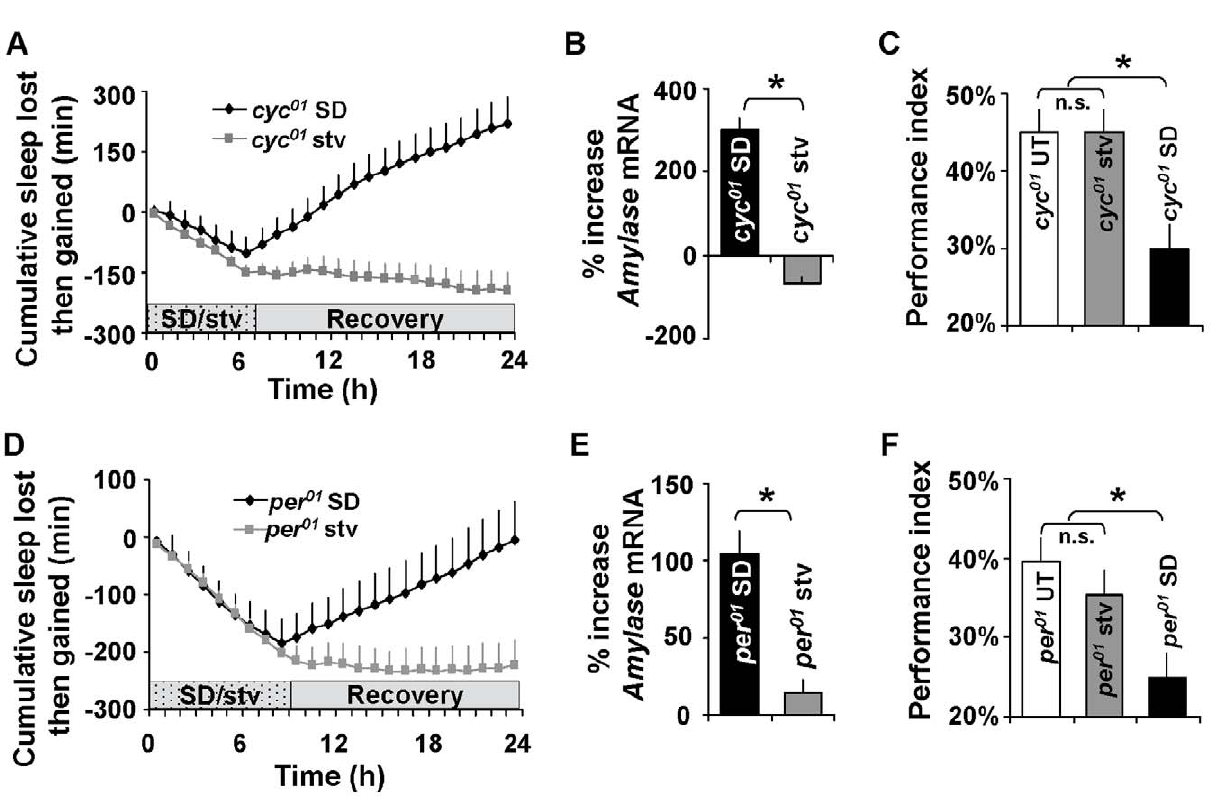
Figure 1. Starvation produces a waking state that does not activate sleep homeostasis. (A) cyc 01 flies show a large homeostatic response after 7 h of sleep deprivation (SD, black) but do not display a homeostatic response following waking induced by 7 h of starvation (stv, gray). The sleep deprivation and starvation experiments were conducted in parallel on female siblings whose baseline sleep was monitored for 3 d; experiments were conducted in constant darkness (DD). Cumulative sleep lost or gained during SD or starvation. A negative slope indicates sleep lost, and a positive slope indicates sleep gained; when the slope is zero, recovery is complete. Stippled bar indicates treatment and white bar indicates recovery ( n =72 for each group, data are presented as mean 6 SEM). (B) Amylase mRNA for sleep deprived and starved cyc 01 flies expressed as a percentage change from age-matched untreated controls as measured by QPCR ( n =3 replicates of 20 heads/group; * p , .05 Student’s t test). (C) APS performance is significantly disrupted by SD but is unchanged following starvation in cyc 01 flies. The performance index is the number of photonegative choices during the last 4 trials of a 16-trial test; a higher score indicates learning. One way ANOVA F [ 2,30 ] =5.26; n =10/group; * p , .05 modified Bonferroni Test. (D) per 01 flies show a large sleep rebound following 7 h of sleep deprivation but do not display a homeostatic response following 7 h of starvation ( n =72 for each group). (E) Amylase mRNA for sleep deprived and starved per 01 flies expressed as a percentage change from age-matched untreated controls as measured by QPCR ( n =3 replicates of 20 heads/group; * p , .05 Student’s t test). (F) APS performance is significantly disrupted by SD but is unchanged following starvation in per 01 flies. One way ANOVA F [ 2,26 ] =2.6; * p , .05 modified Bonferroni Test.